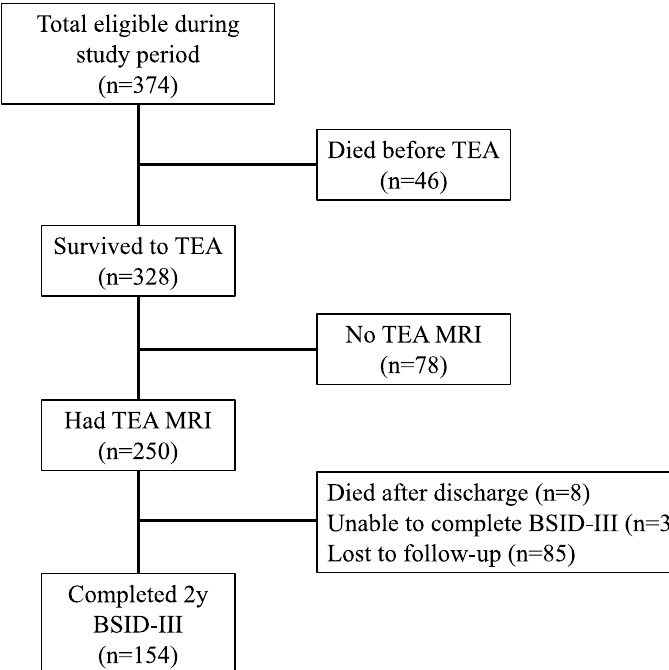
Figure 1. Flow diagram of patient selection.